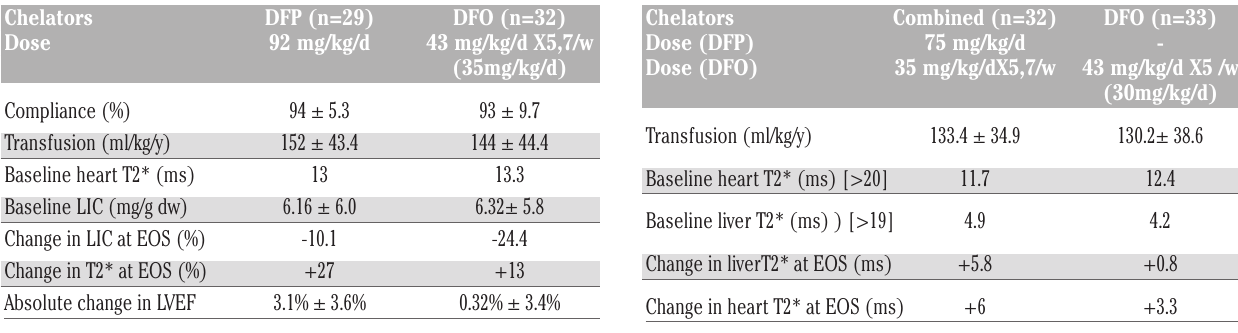
Table 6. Descriptives of study group at baseline and the change in LIC, myocardial T2* and LVEF at the end of study (Data from Pennell, D. J. et al. Blood 2006;107: